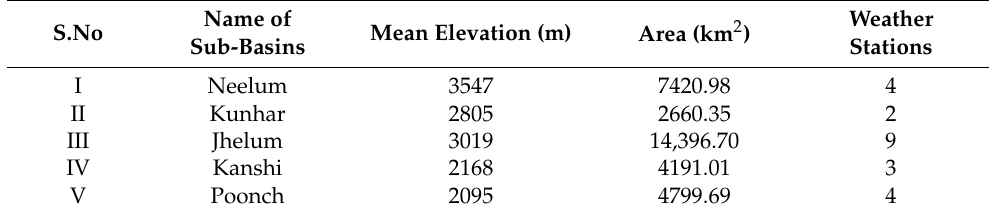
Table 1. Topological information of five sub-basins of JRB.